Question: Describe this figure in one sentence.
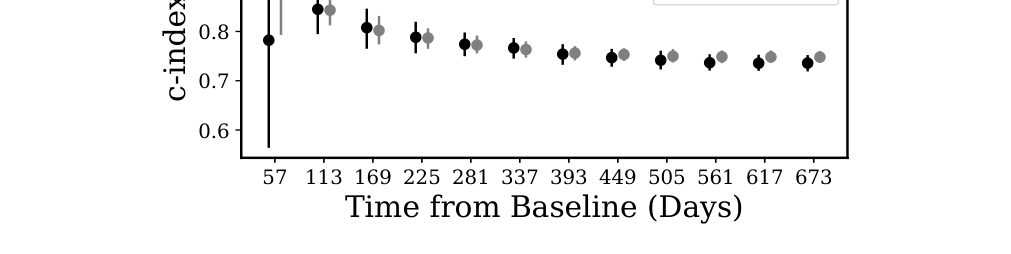
Answer: Evaluation of the TTE model for ALS time to death outcome. In the top panel we compare the observed and predicted survival curves for the two top cohorts defined in Table 6. The bottom panel reports concordance index as a function of time. Concordance index at a given time assumes that all observed events after that time are censored. Error bars indicate 95% confidence intervals.